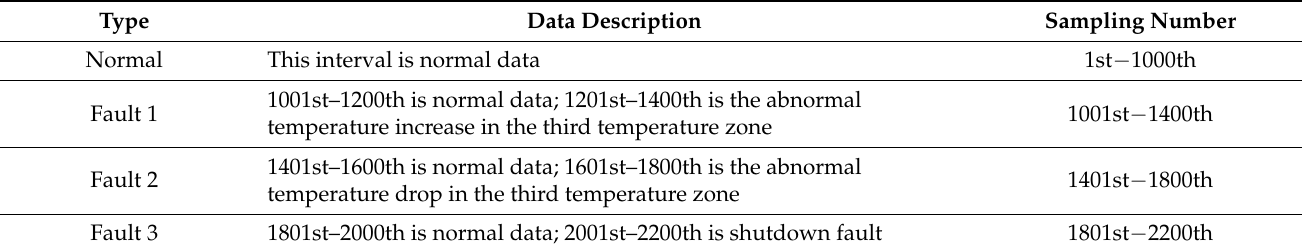
Table 1. Process data